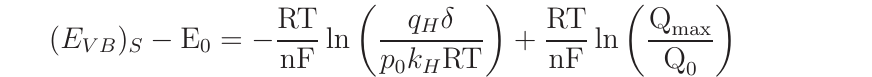
Table 1 Shift of the peak wavelength, or of the energy of the maximum ((E V B ) s − E to Eq. (16) of the electroluminescence spectrum during the anodic oxidation of porous silicon layers of different porosities. Values of λ max and of Q max /Q 0 were taken from the work of Herino